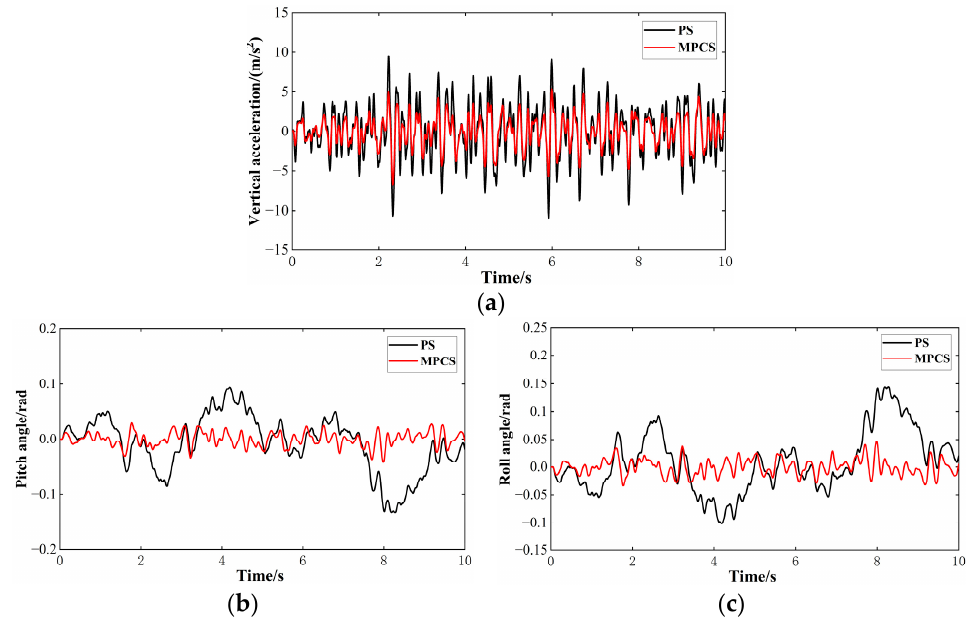
Figure 11. Simulation results of random road attitude control: ( a ) Heaving acceleration of car body;